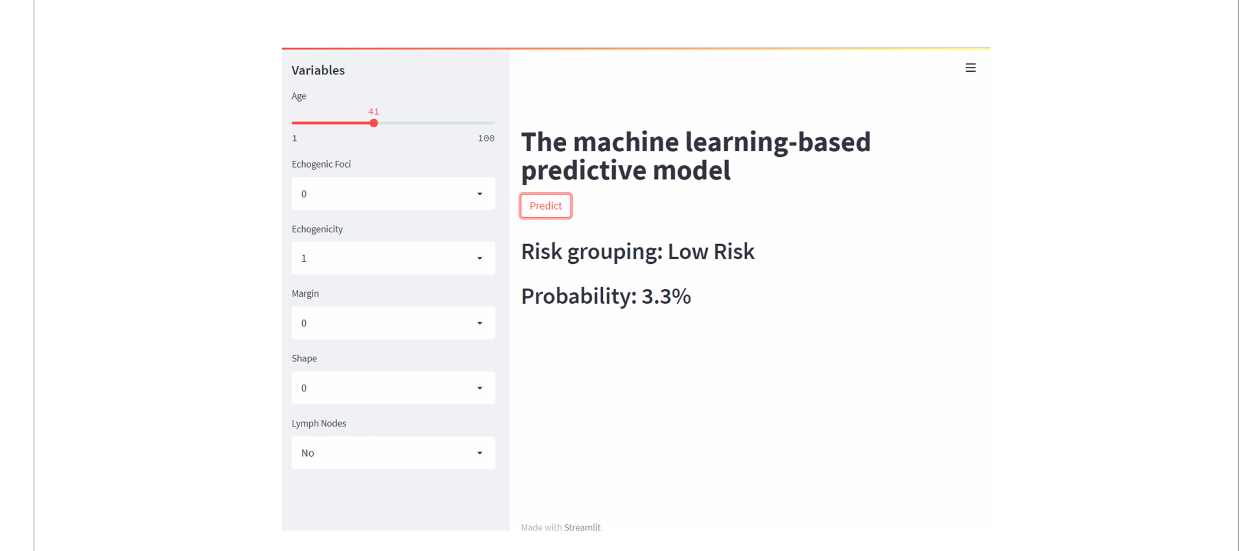
FIGURE 8 The application of the web risk calculator for patients with malignant